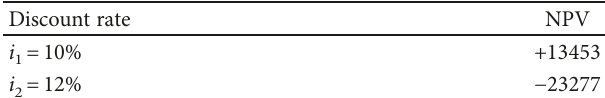
Table 5. The costs of the main parts of the solar PV system are given in Table 6.